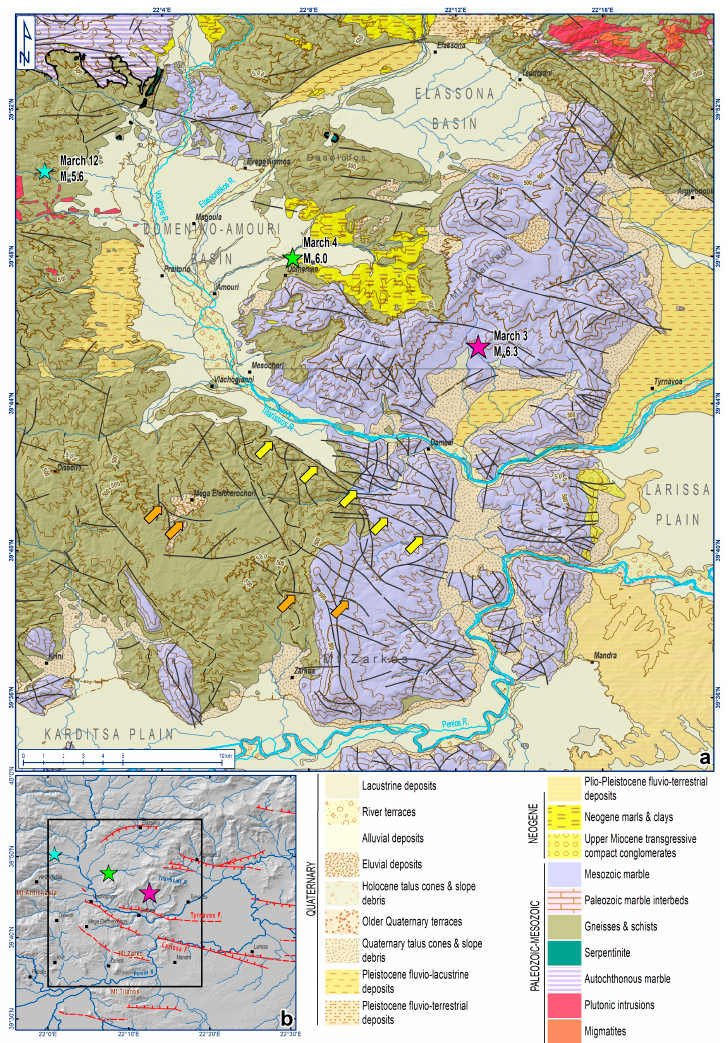
Figure 1. ( a ) Geological map (based on the 1:50,000 scale geological maps of IGME [12–15]) of the 2021 epicentral area showing the alpine (Mesozoic-Paleozoic) formations simplified, and the post- alpine deposits. The yellow and orange arrows point the basement faults (Titarissios and Zarkos fault respectively) recognized in the geological maps of IGME that were reactivated during the 2021 sequence. ( b ) Hillshade map of northern Thessaly showing the active faults and the location of ( a ) map. The two mainshock epicentres are marked with stars in both ( a , b ) as well as the 3rd